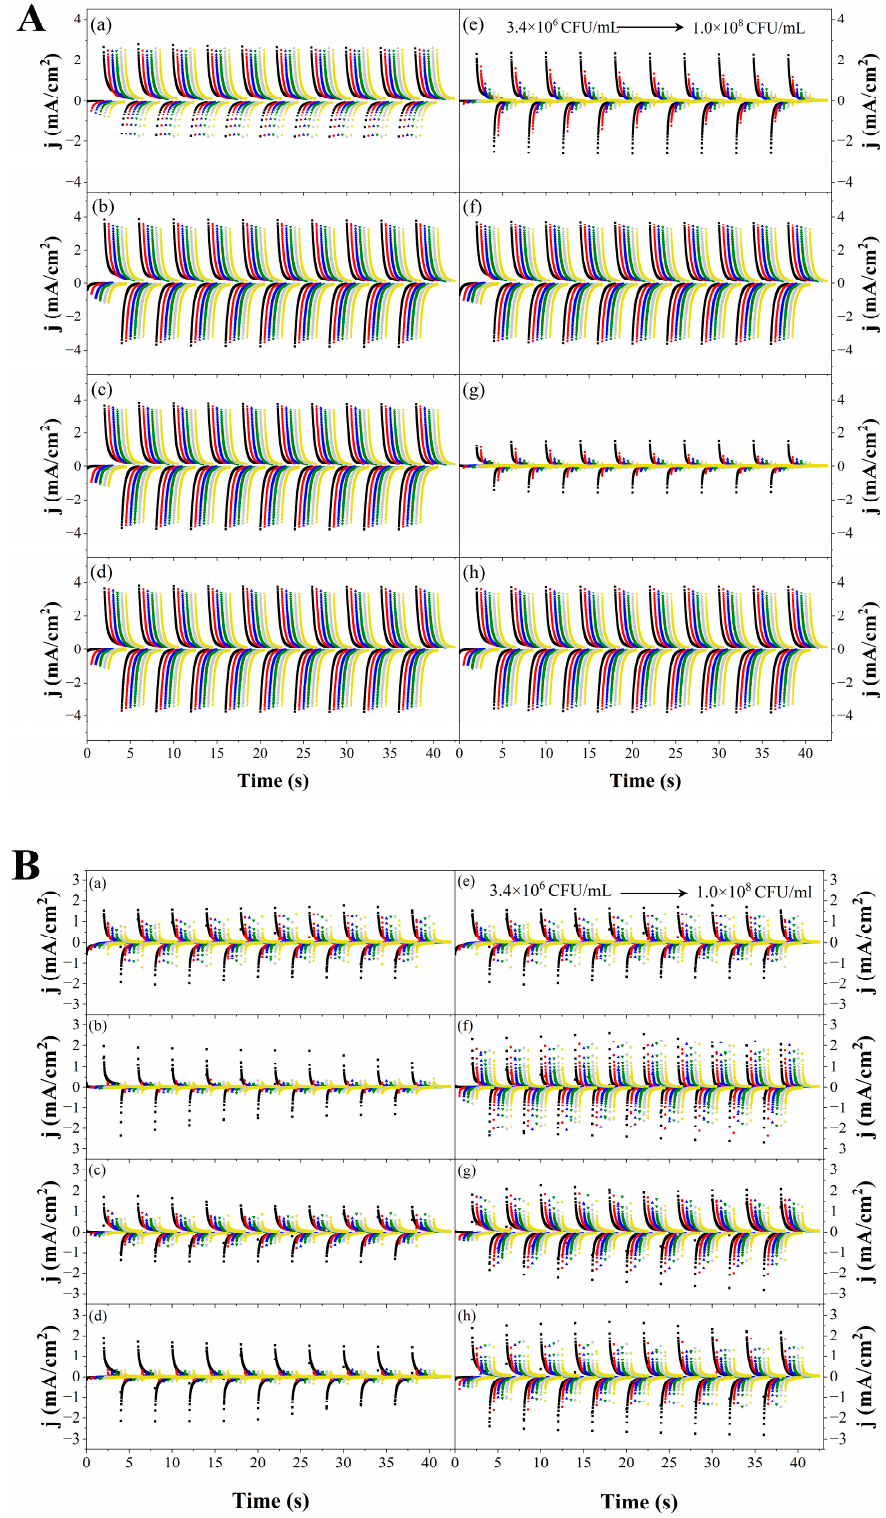
Figure 4. Current density vs. time determined by NIP-Ppy/SPCE ( a – d ), MIP-Ppy/SPCE ( e – h ) electrodes ( A ) and NIP-Ppy/Pt ( a – d ), MIP-Ppy/Pt ( e – h ) ( B ), with a concentration range of 3.4 × 10 6 , 1.0 × 10 7 , 2.3 × 10 7 , 4.0 × 10 7 , 6.7 × 10 7 , 1.0 × 10 8 CFU/mL Listeria monocytogenes bacteria, prepared using di ff erent extraction solutions:10% acetic acid ( a , e ), 0.05 M sulphuric acid ( b , f ), 10 U/mL trypsin ( c , g ), and 1% L-lysine ( d , h ) to remove Listeria monocytogenes bacteria from imprinted cavities.